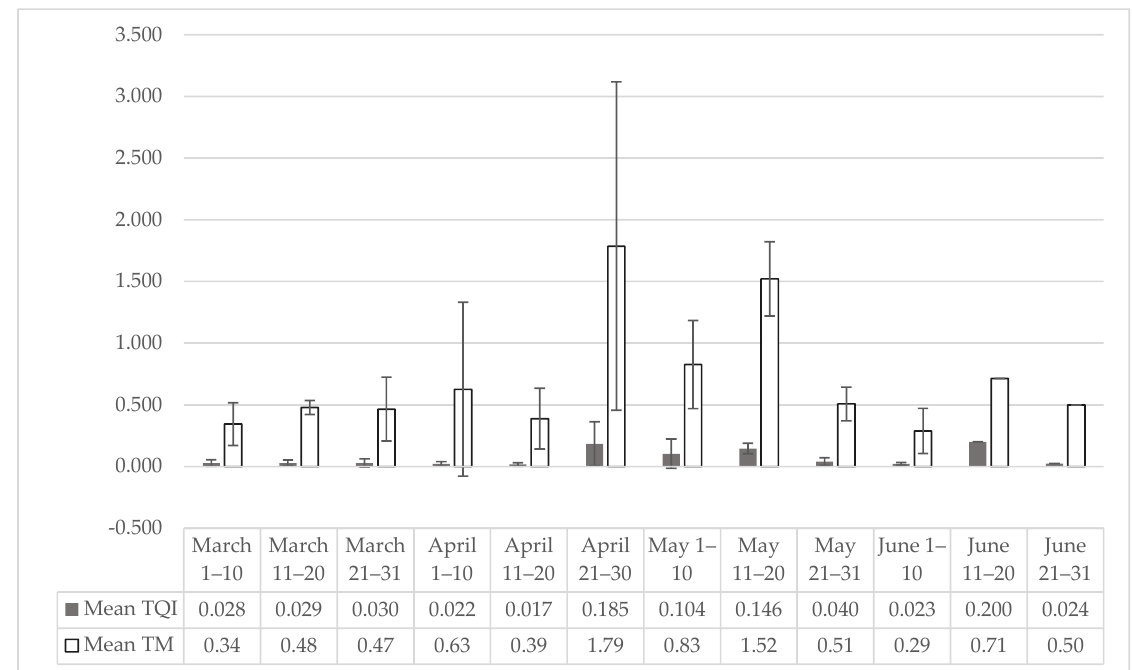
The active questing activity of I. ricinus began in March, peaked in end of April and declined in June. Using the mean values of TQI and TM for a period of five years, we detected the highest activity within the last 10 sampling days in April (Figure 1 and Table 3). No autumn activity was surveyed due to unfavourable weather conditions and impassibility at some of the sampling sites.